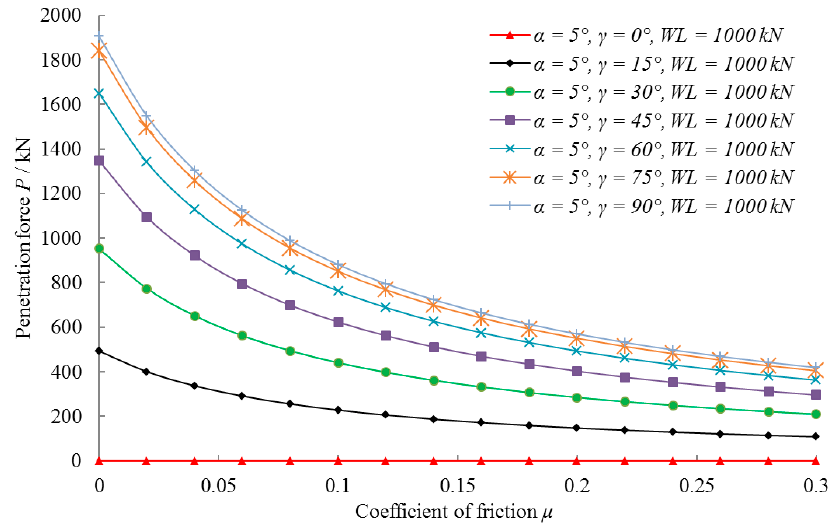
Figure 16. Relationship between the penetration force P and fiction coefficient μ .